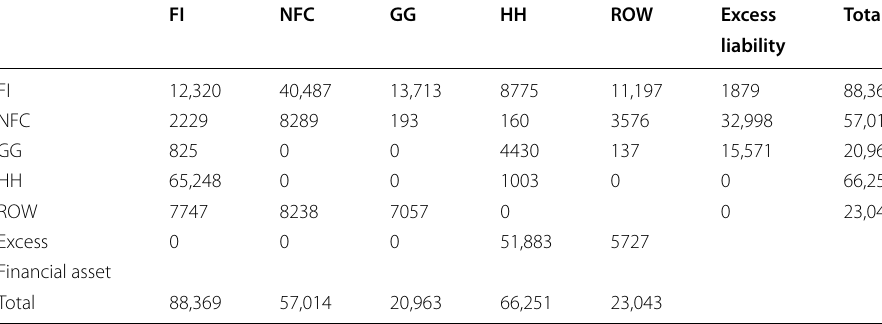
Source: created by authors using OECD.Stat data